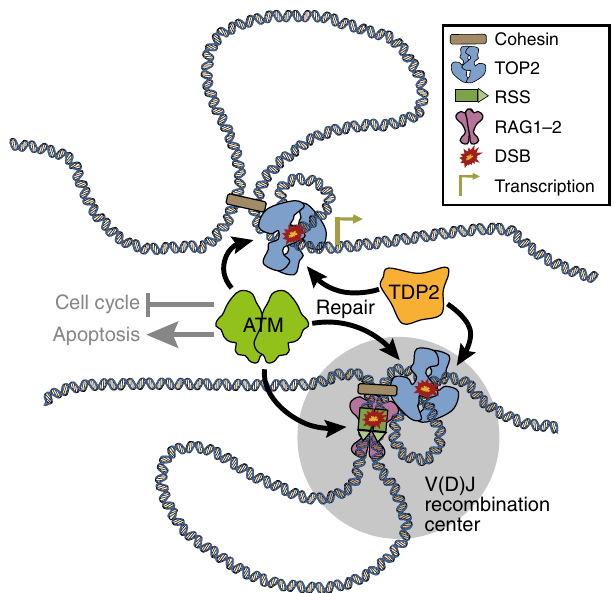
Fig. 8 Model to explain aberrant TOP2 activity as a driver of ATM- de fi cient thymic malignancies. TOP2 activity associated with genome organization and transcription throughout the genome can accidentally result in DSBs (top). Additionally, DSBs can arise as a consequence of TOP2 activity derived from genomic reorganization associated to V(D)J recombination, and in particular, the mechanism of RAG scanning to fi nd its RSS targets (bottom). These DSBs concur with RAG-mediated DSBs, increasing the probability of oncogenic translocations to occur. Ef fi cient repair of TOP2-induced DSBs mediated by either TDP2 or ATM-dependent pathways, together with the checkpoint and apoptotic functions of ATM, strongly limit the oncogenic potential of these